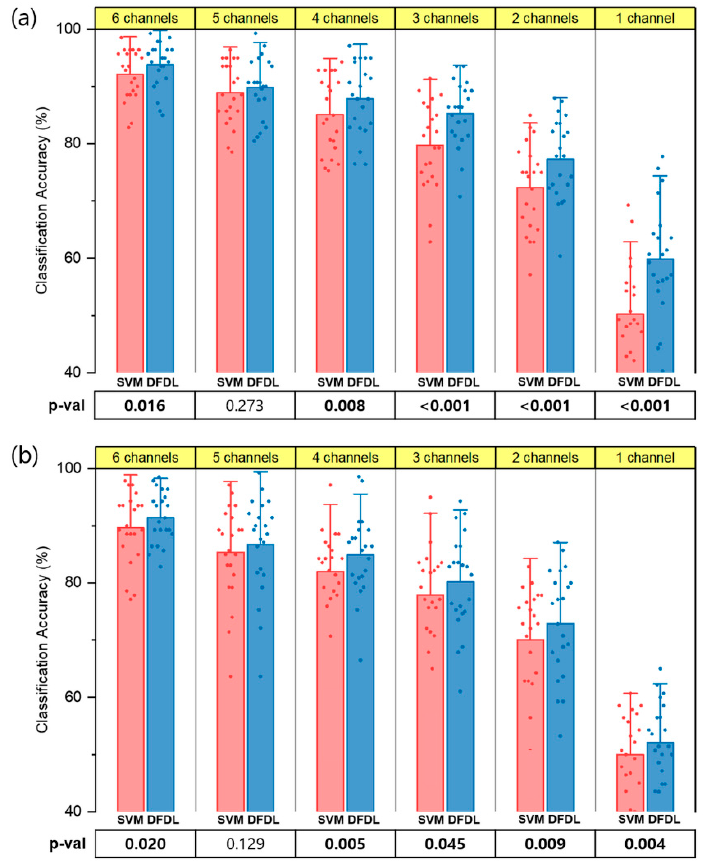
Figure 4. The average classification performance of DFDL and SVM_rbf for different numbers of channels. Overall, the performance of DFDL was better than that of SVM_rbf, and the gap became more obvious as the number of channels decreased. ( a ) The targeted method. ( b ) The untargeted method. Each dot indicates the classification accuracy of each subject. The error bar represents the standard deviation. Bold values indicate significant differences.